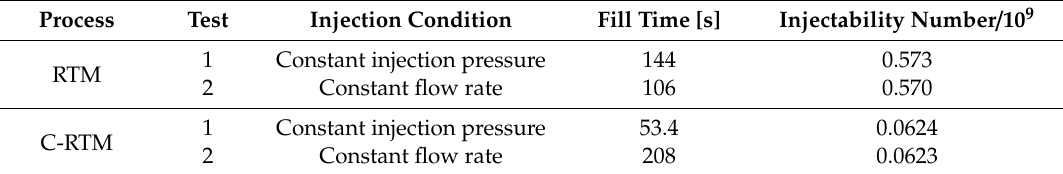
Table 6. Fill times and injectability numbers for filling cases of the second hood geometry.